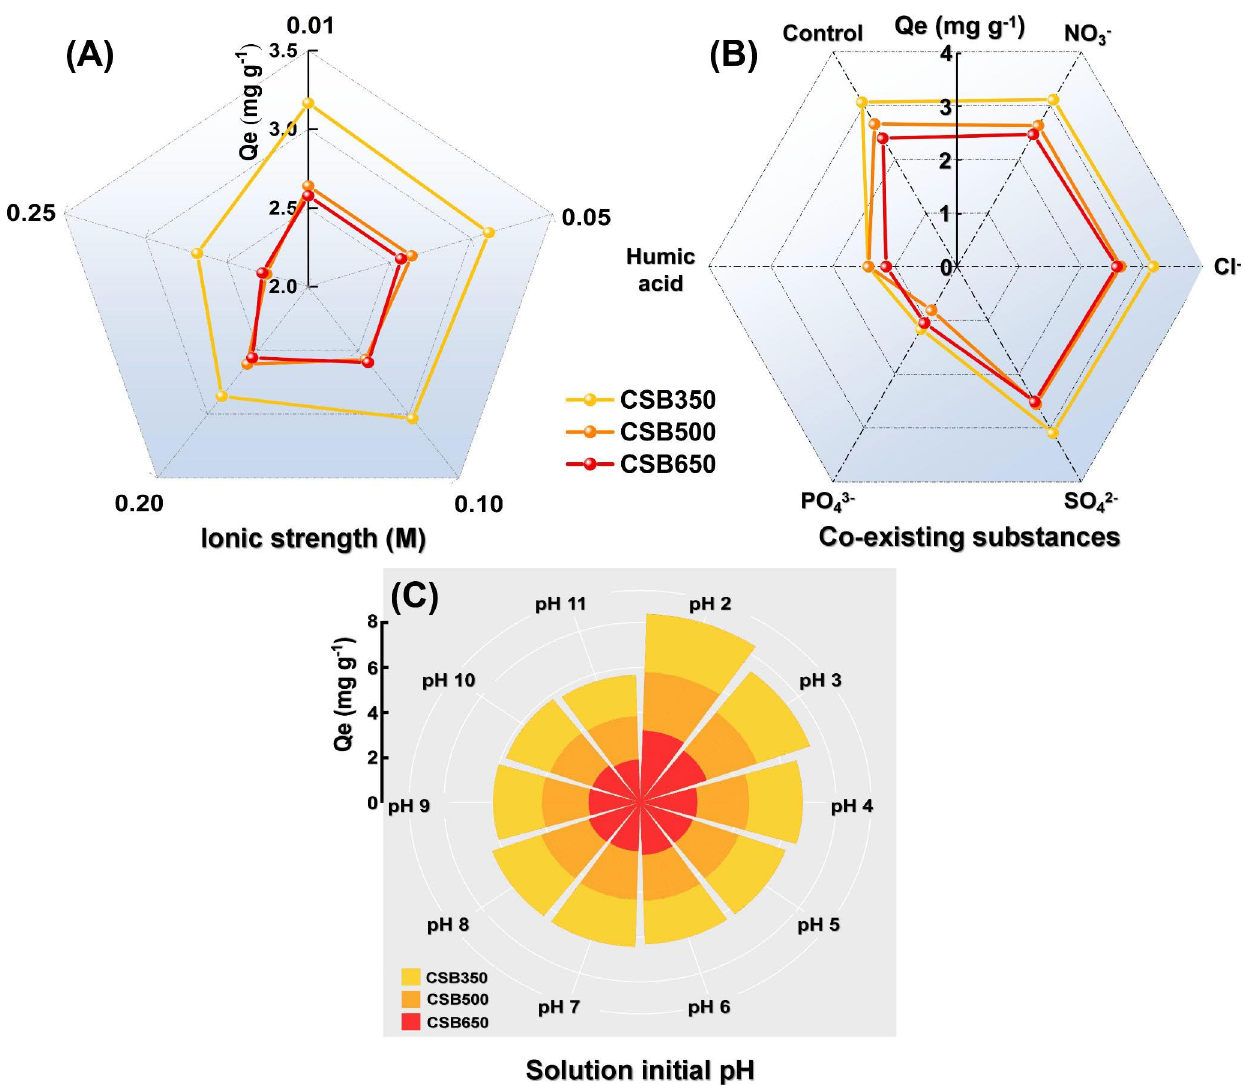
Fig. 4 Effects of ionic strength (A), co-existing substances (B), and initial solution pH (C) on Sb(III) adsorption by crawfish shell biochar (CSB) pyrolyzed at 350 ° C (CSB350), 500 ° C (CSB500), and 650 ° C